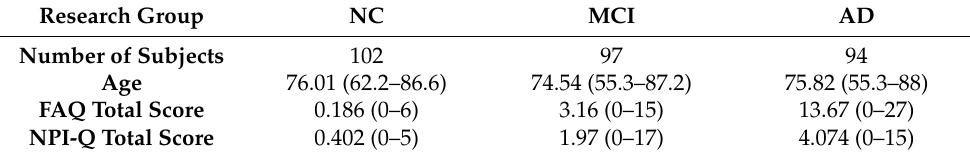
Table 1. Demographics of subjects with PET scans presented in mean (min–max) format. Research